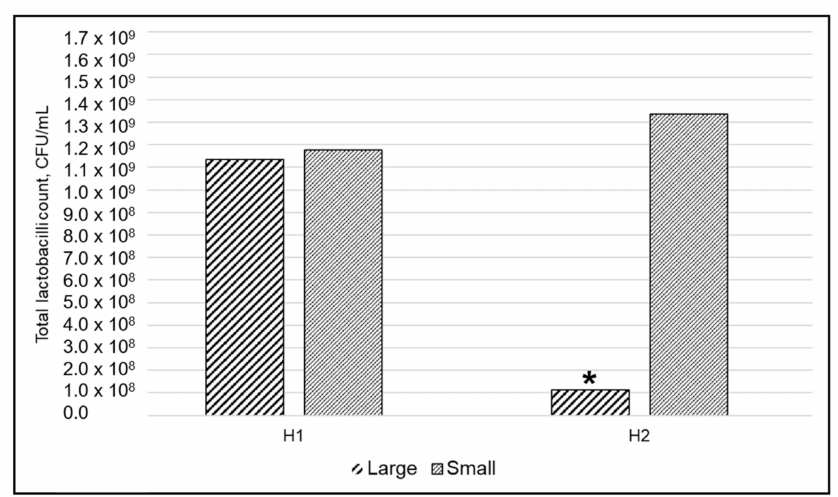
Figure 2. Back-transformed EM means of the lactobacilli count in piglets born small or large in two herds (H1 and H2) analyzed by mixed model ( n = 30). * Significant difference between small and large piglets was found in H2 ( p =